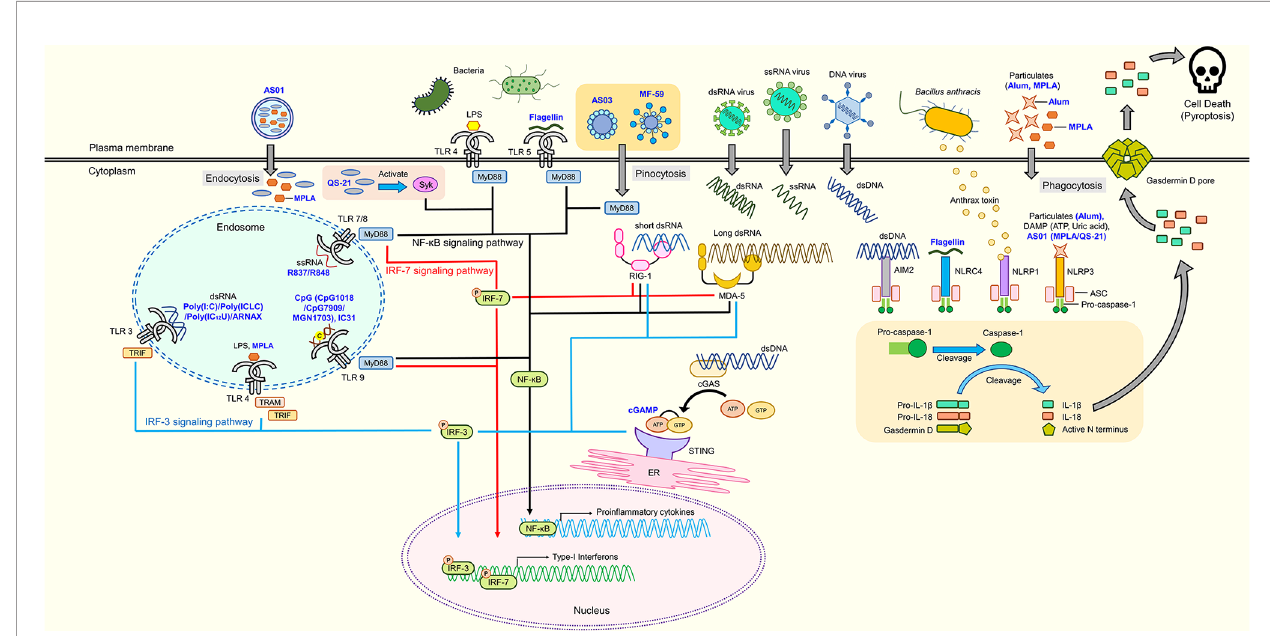
FIGURE 1 | Adjuvant candidates and their respective receptors. TLR4 and TLR5 are expressed on the cell surface, while TLR3, TLR4, TLR7, TLR8, and TLR9 are expressed in endosomes. TLR4, TLR5, TLR7, TLR8, and TLR9 initiate signaling through the MyD88 pathway to activate NF- k B, which induces the production of proin fl ammatory cytokines. Activated Syk elicits the production of proin fl ammatory cytokines through the NF- k B signaling pathway. RIG-1 and MDA-5 are intracellular nucleic acid sensors that induce both proin fl ammatory cytokines and type-1 interferons via MyD88 and IRF signaling pathways. cGAS produces cGAMP that activates the cGAS-stimulator STING located on the ER to induce production of proin fl ammatory cytokines through the NF- k B signaling pathway. In fl ammasomes (AIM2, NLRP1, NLRP3, and NLRC4) cleave pro-caspase 1 into caspase 1 that subsequently cleaves pro-IL-1 b , pro-IL-18, and Gasdermin D into their mature forms, respectively. N-terminal Gasdermin D oligomerizes to form pores, inducing pyroptosis. Blue text represents adjuvant candidates discussed in this